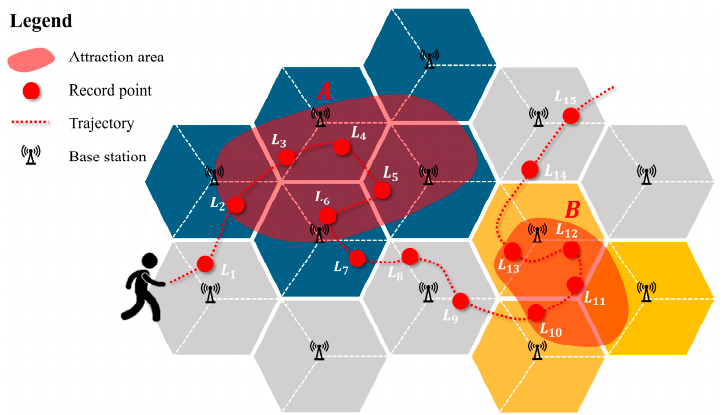
Figure 2. A user’s record of points and trajectory in the process of sightseeing. L 1 – L 15 represent the location of recorded points from mobile tracking data. Points at attraction A ( L 2 – L 6 ) record the